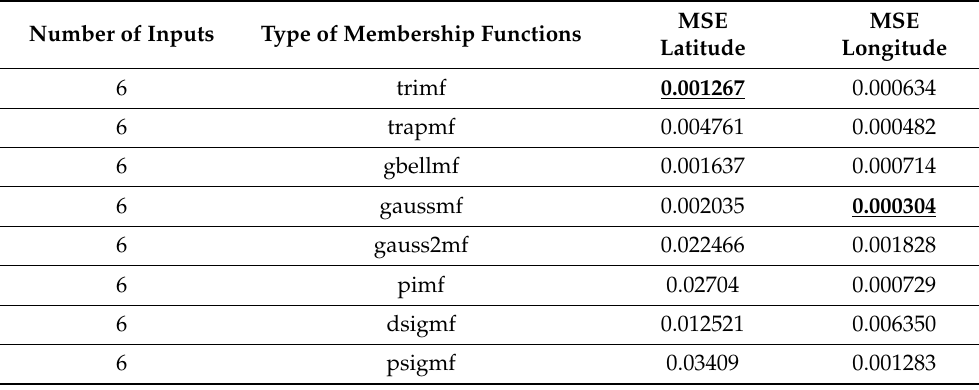
Table 2. Proposed architecture